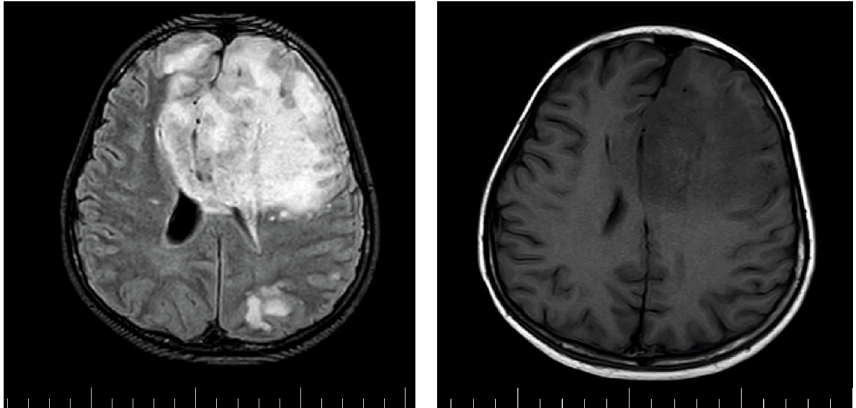
Figure 4: Brain MRI: di ff use abnormal signal foci had seen in both hemispheres, and the largest one is in the left frontal, left temporoparietal, and right occipital regions along with peripheral vasogenic edema.